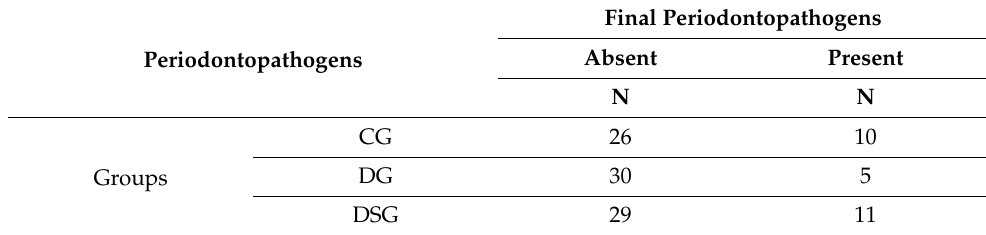
Table 4. The final results of periodontal diseases in the three groups at the end of the research period.